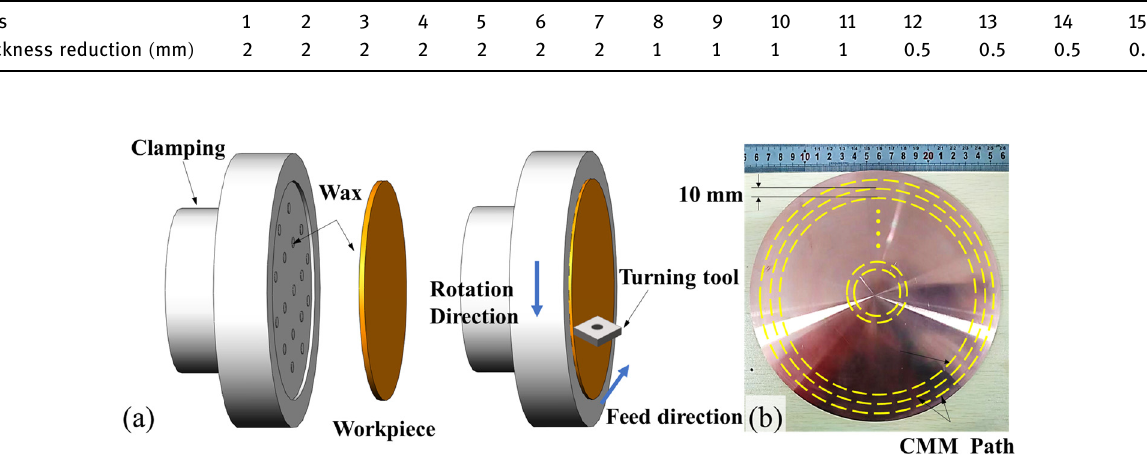
Figure 3: ( a ) Experimental setup of turning and ( b ) CMM path in the fi nal part with a diameter of 200 mm and a thickness of 3.5 mm.